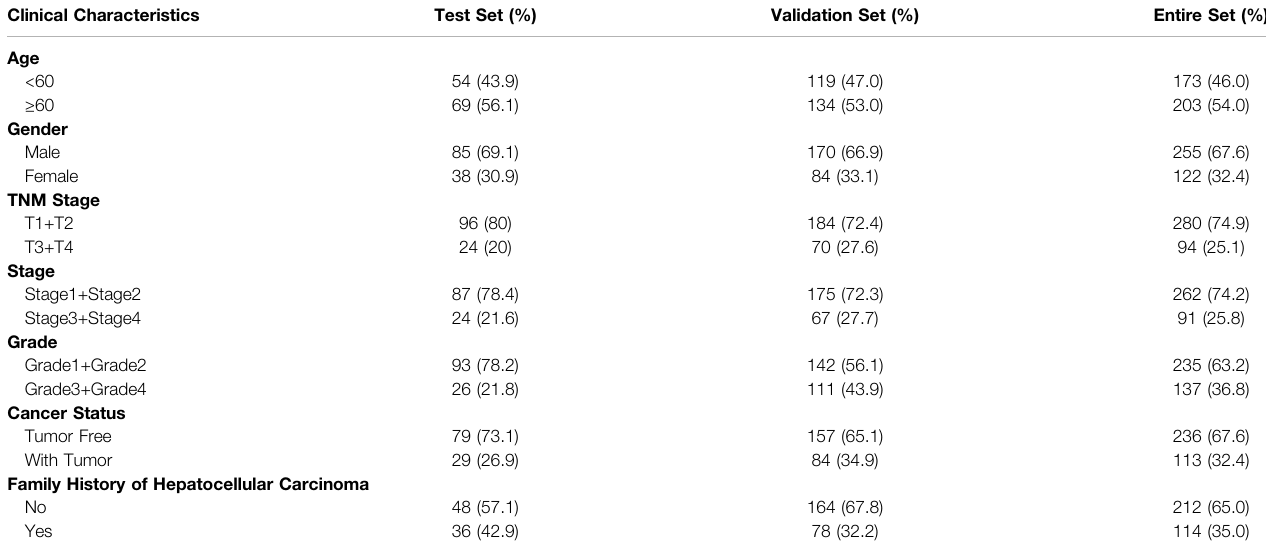
TABLE 1 | Clinical characteristics of patients with hepatocellular carcinoma in each set. Clinical